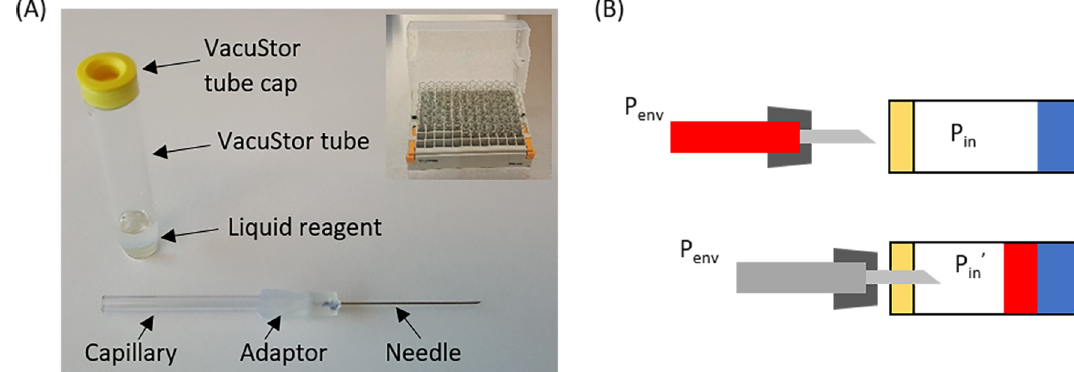
Fig 2. Threshold vacuum testing setup. (A) Image of a VacuStor tube and a capillary-needle assembly. The insert shows a 96-tube rack; (B) Schematics of VacuStor tube system before and immediately after transfer of all the blood.